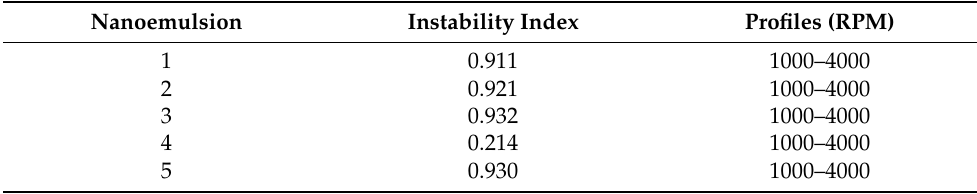
Table 4. Instability index of the formulations defined by factorial